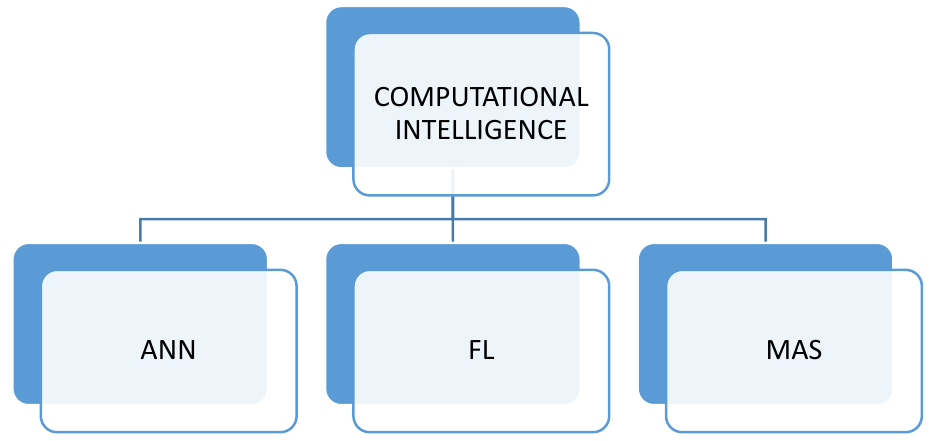
Figure 15. Computational intelligence techniques.